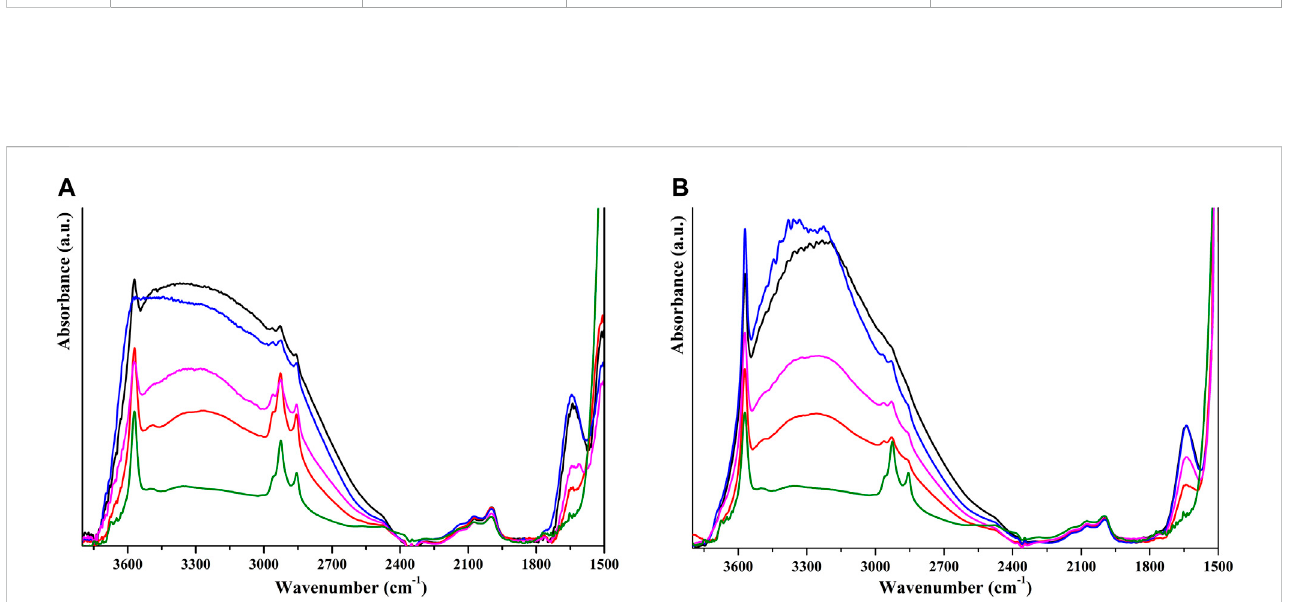
mg of absorbed acids